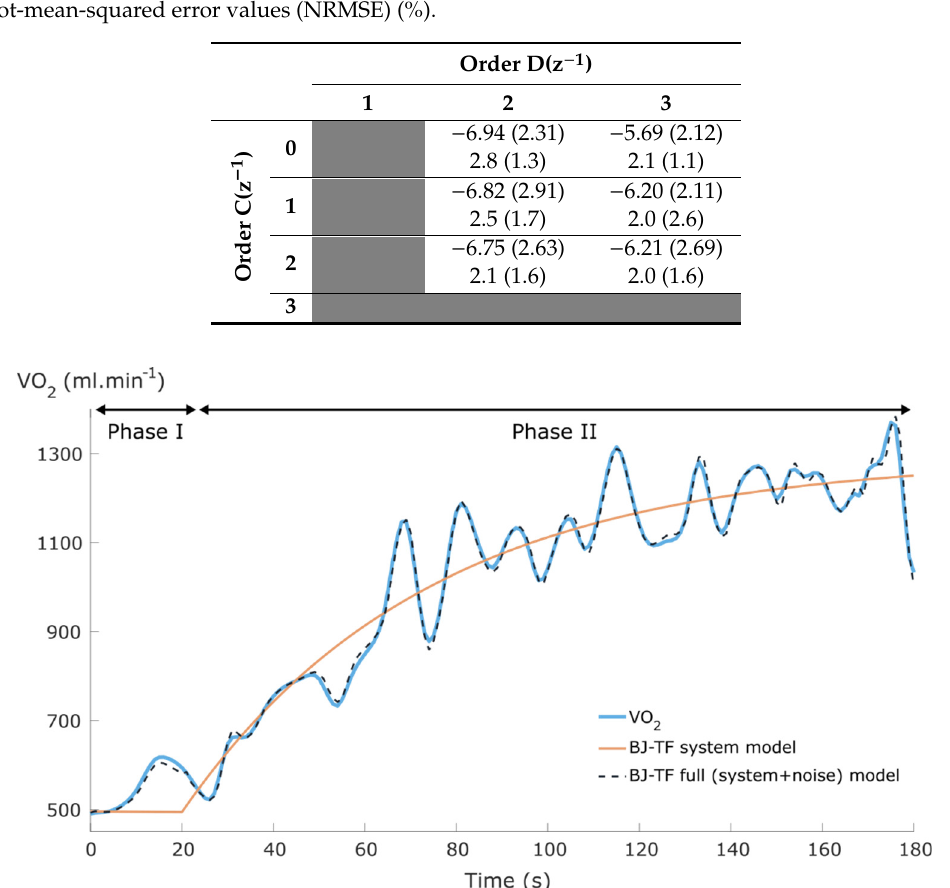
Figure 4. Example plot of VO 2 data and the BJ-TF system and full (system + noise) model. The estimated TD value was 20 s.